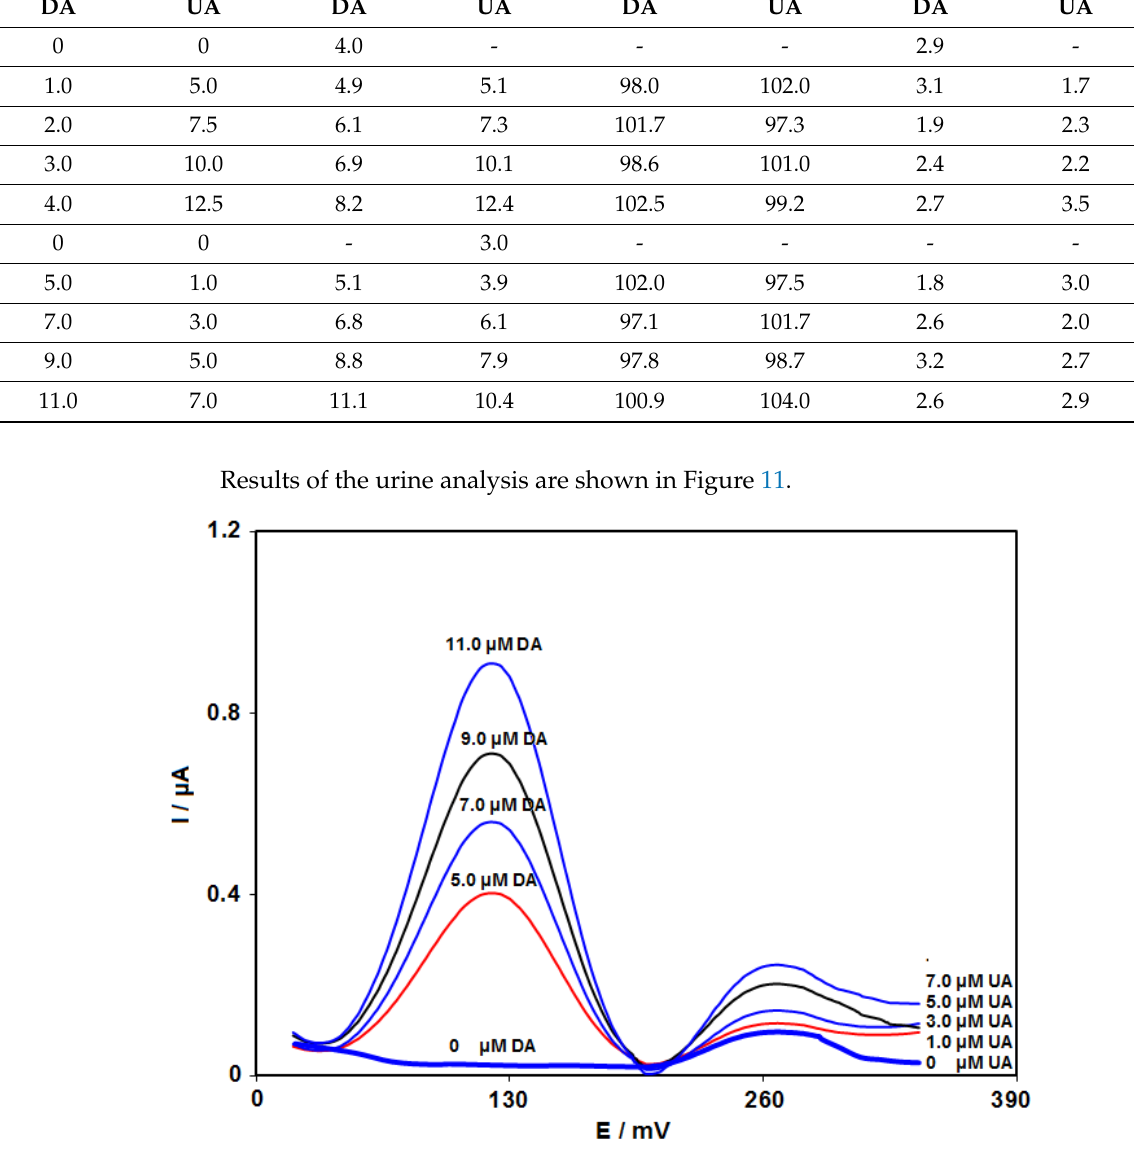
Figure 11. SWVs of CoMOF-GO/1-M,3-BB/CPE in urine samples with variable DA and UA concen- trations.